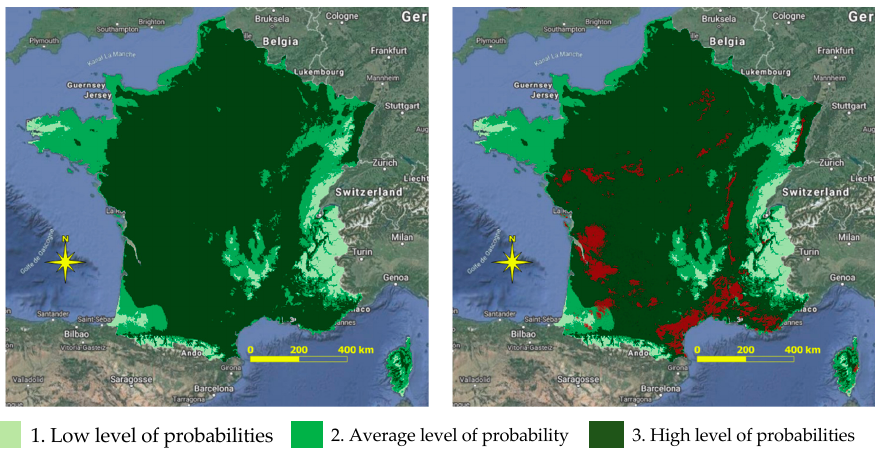
Figure 5. Potential suitable areas for grapevine crop according to baseline climate. Grapevine crops declared in 2018 are represented in red. Table 2. Percentage and ha of grapevine crops in the probability classes to find suitable area.